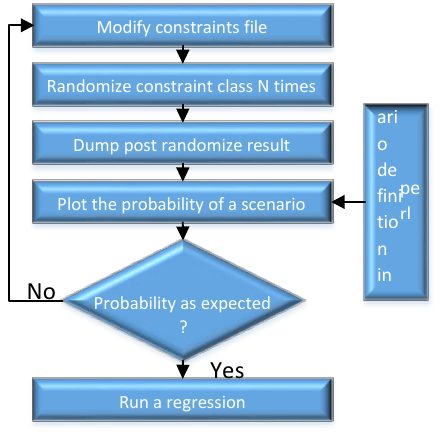
Fig. 6. Stimulus control with Probability Calculator